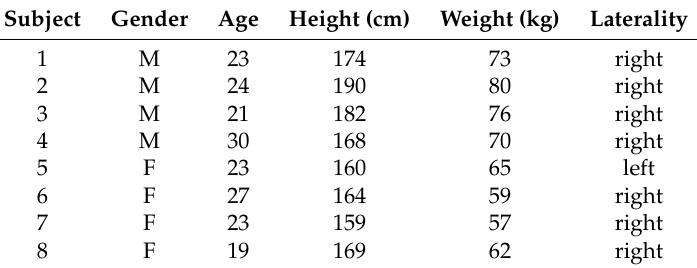
Table 1. characteristics of the subjects in the database.